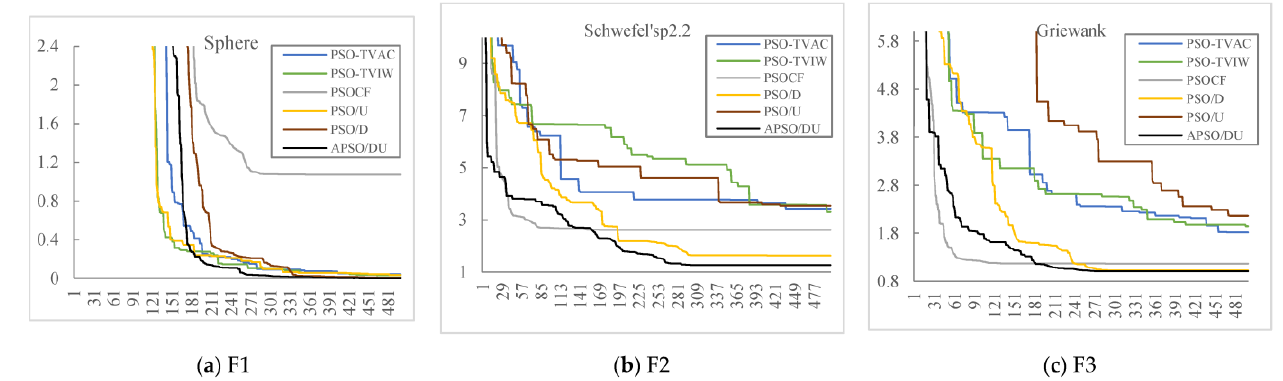
Figure 3. Curves of the convergence process of the benchmark test functions F1-F3.